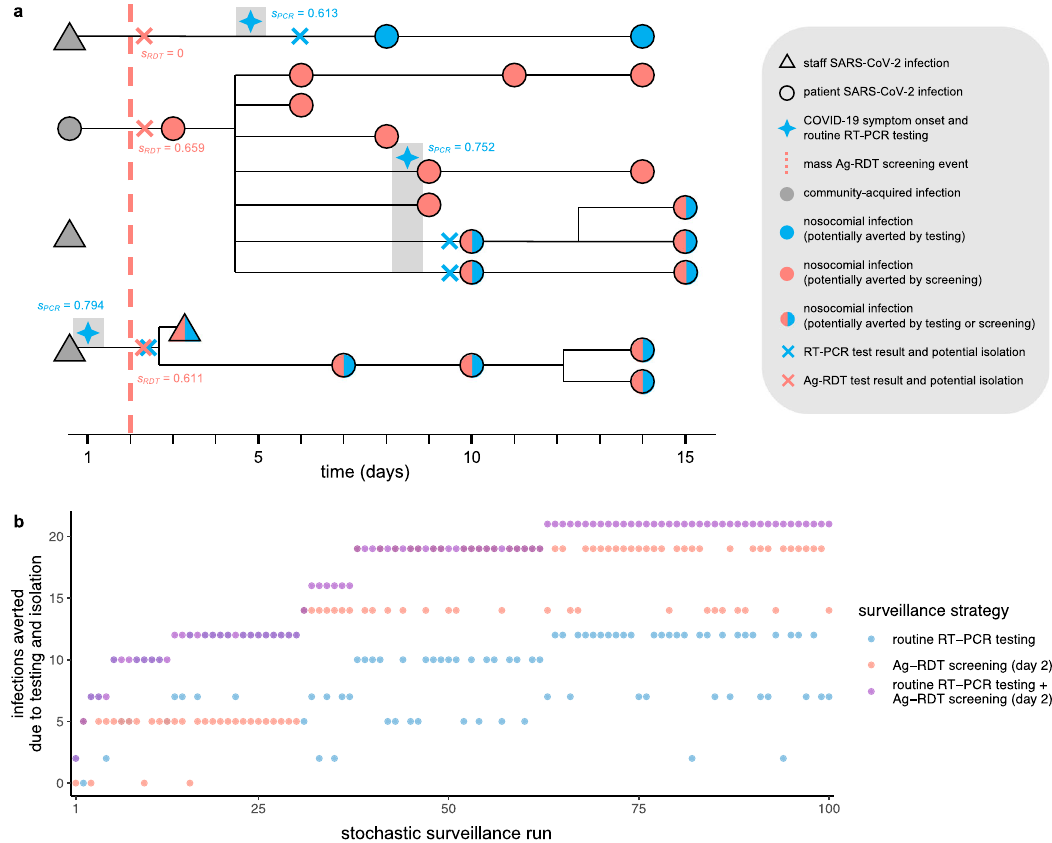
Fig. 5 Surveillance interventions were applied retrospectively to simulated SARS-CoV-2 outbreaks, illustrated here using data from outbreak simulation #22 from LTCF 1. a The SARS-CoV-2 transmission chain, with infections (shapes) transmitted from left to right following black lines. Of four community-onset infections (grey shapes) at simulation outset, three transmitted to other individuals in the LTCF, triggering a nosocomial outbreak. Routine RT-PCR testing was conducted upon COVID-19 symptom onset (blue four-pointed stars), with results and case isolation 24-h later (blue crosses). A population-wide Ag-RDT screening event was conducted on day 2 (red dashed line) with immediate results and isolation (red crosses). Test sensitivity — the probability of a positive test result and subsequent isolation — is given by s adjacent to each test, as determined by infection age t at the time of each test (see Supplementary Fig. S5). Nosocomial infections are coloured blue if potentially averted by routine testing, red if by screening, or both if by either. b Corresponding surveillance results from three selected surveillance interventions evaluated over 100 stochastic surveillance runs. The multi-level testing + screening intervention always averted at least as many infections as either individual intervention in the same run, demonstrating matching of “ controlled ” and “ uncontrolled ” epidemics across interventions, and its relevance for calculation of marginal bene fi ts of multi-level